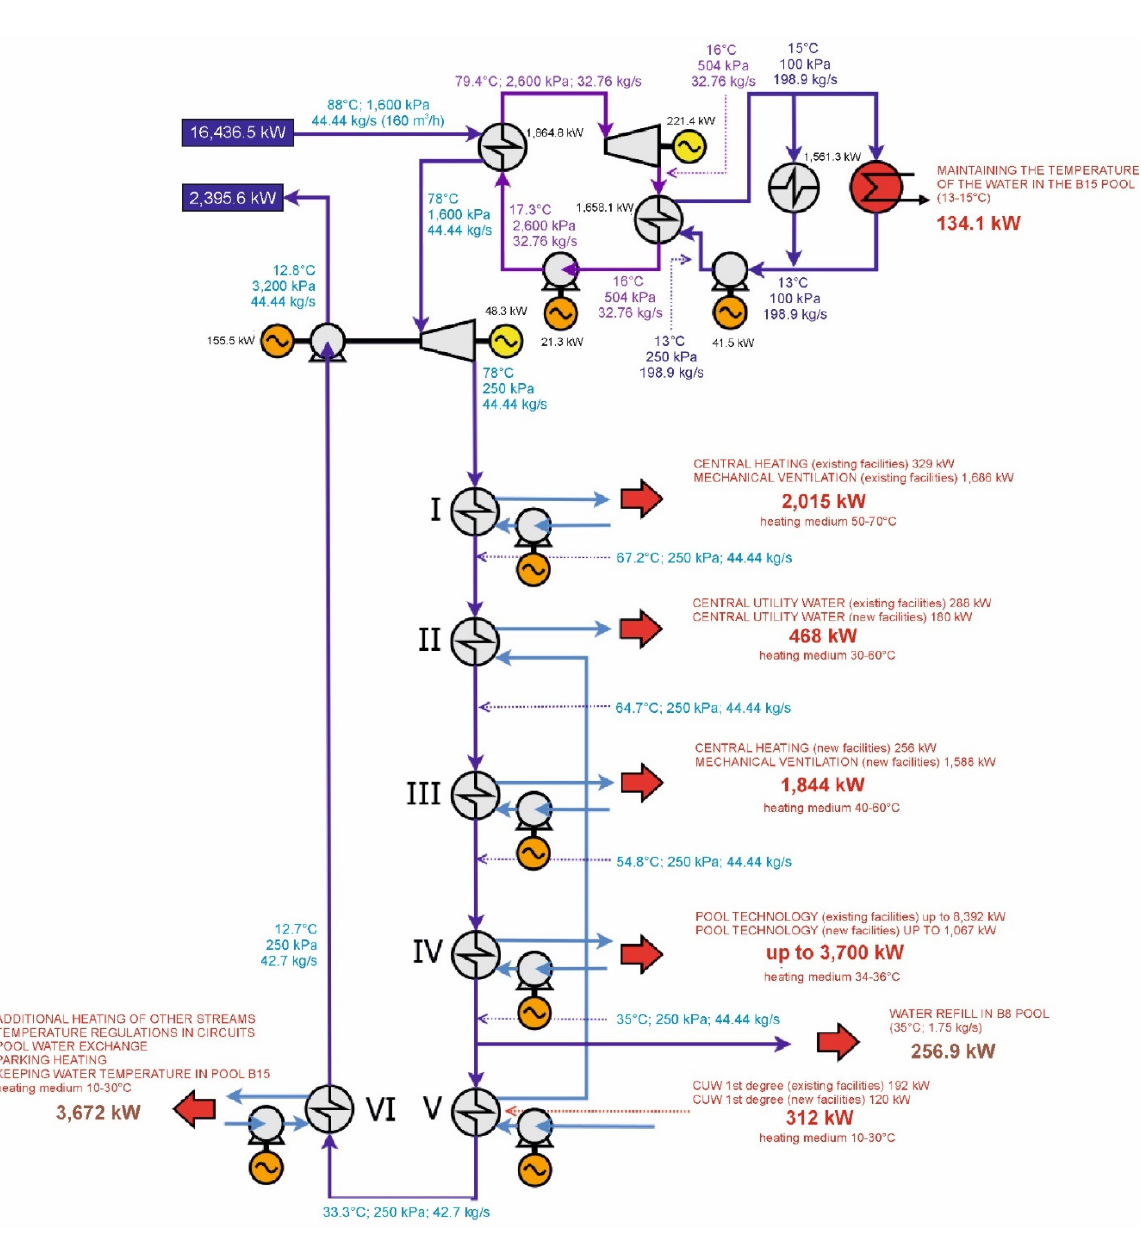
Figure 5. Technological scheme of the geothermal heating plant and ORC power plant, with specified parameters for nominal power operation.